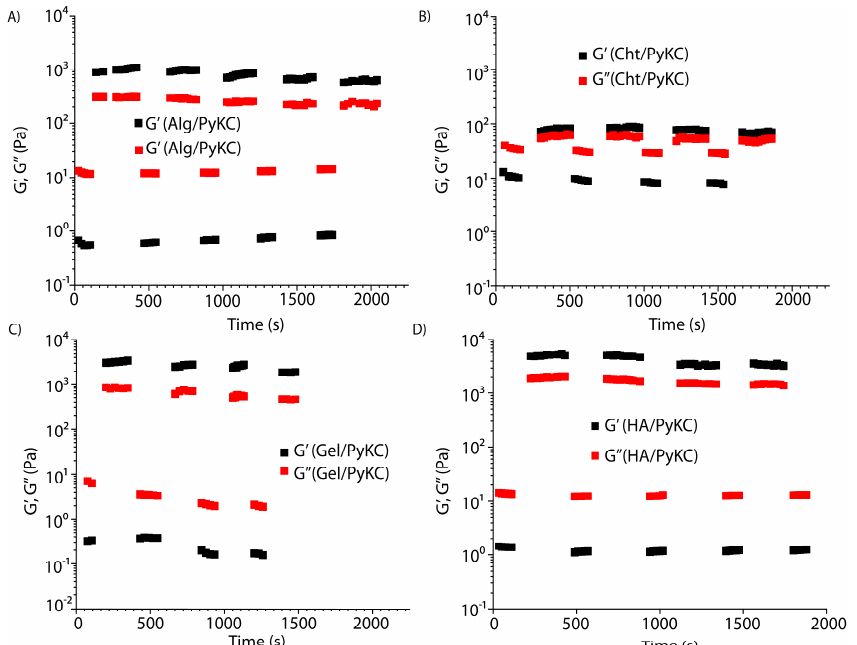
Figure 3. Thixotropic behavior of the composite hydrogels ( A ) Alg/PyKC, ( B ) Cht/PyKC, ( C ) Gel/PyKC, and ( D ) HA/PyKC as reflected by the continuous step strain measurements at room temperature.